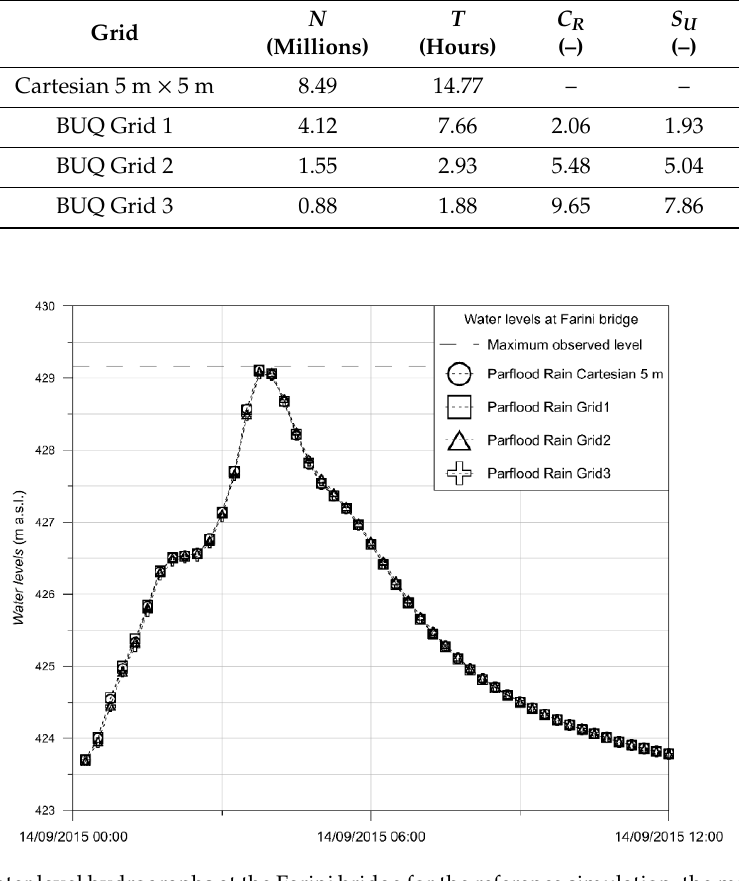
Figure 16. Water level hydrographs at the Farini bridge for the reference simulation, the multiresolution simulations (BUQ Grid 1, 2 and 3) and maximum water observed level.